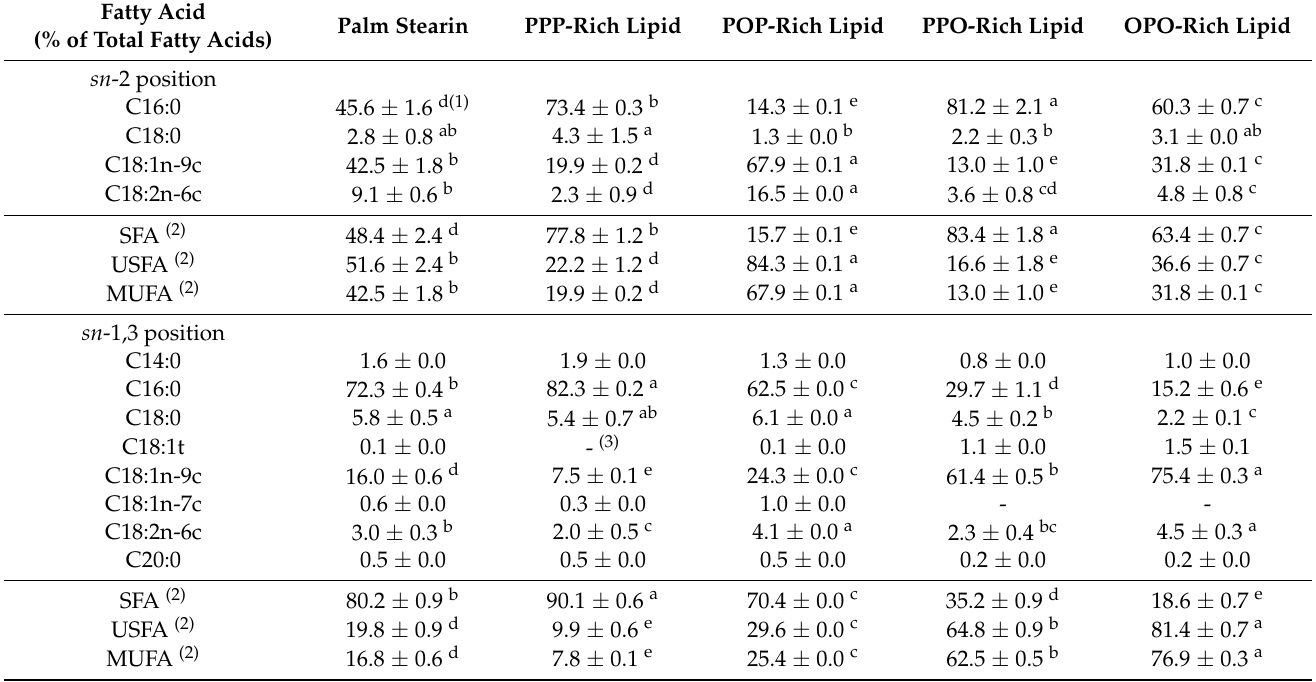
Table 3. The sn -2 and sn -1, 3 positional fatty acid compositions of the